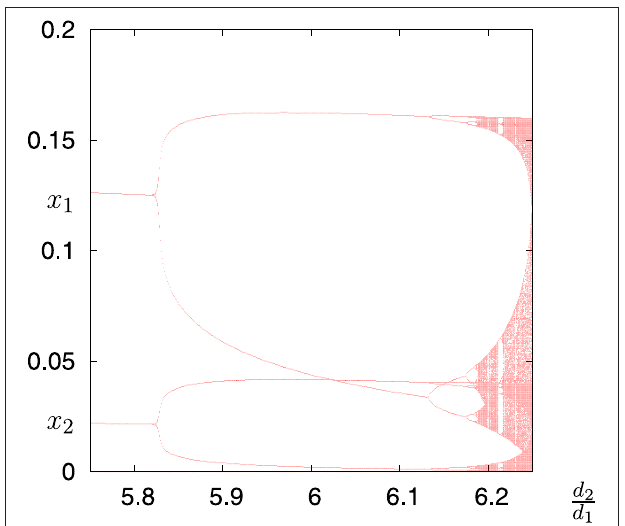
FIGURE 10 | Bifurcation diagram. Amplitudes plotted vs. marginal cost ratio.